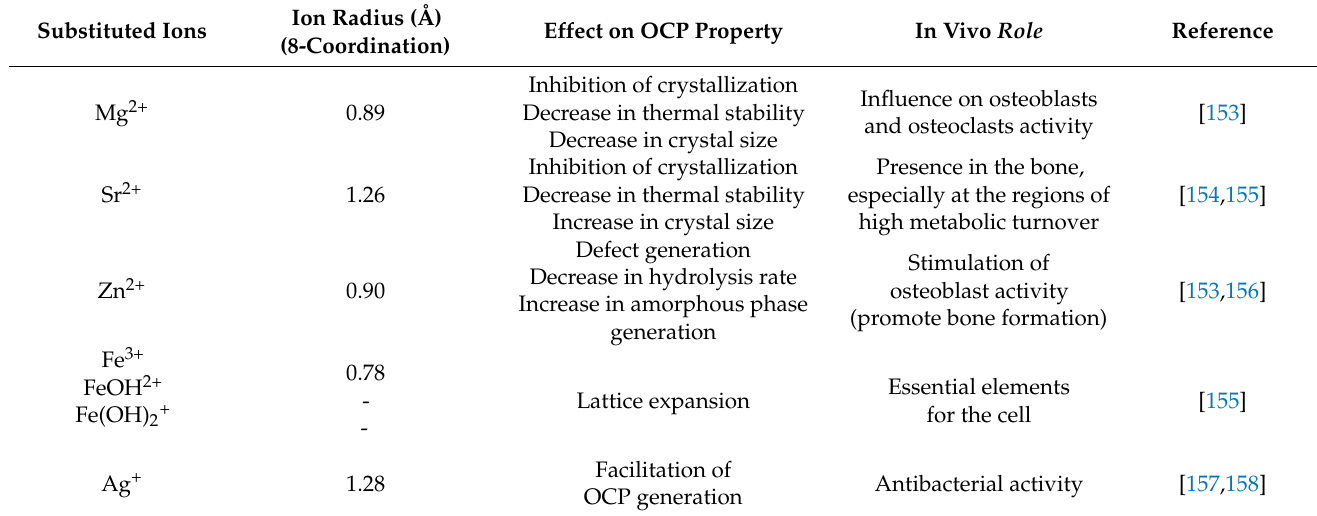
Table 2. Effect on OCP properties and in vivo role of metal ions incorporated into synthetic OCP for biomedical